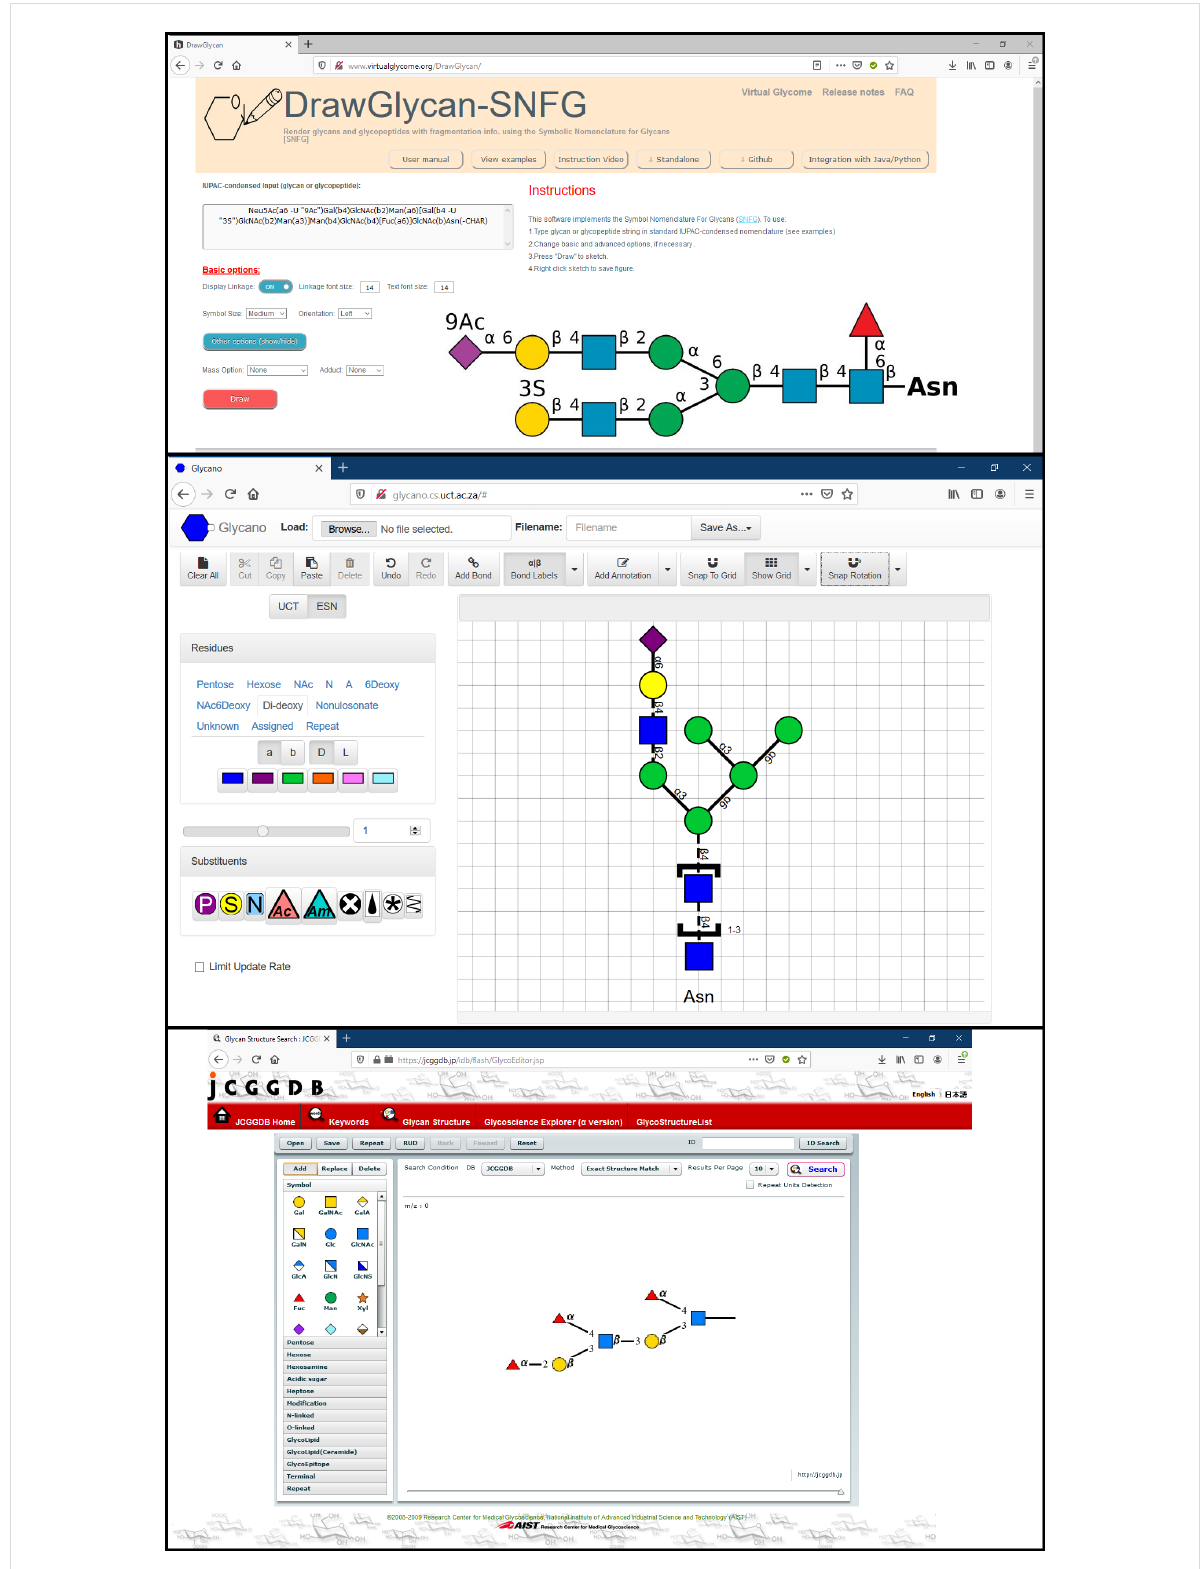
Figure 7: From top to bottom: DrawGlycan-SNFG [51] web interface with a glycan text input and the resulting image output. Glycano [52] interface with a glycan structure. GlycoEditor [53] interface, linkage selection is triggered by adding a new monosaccharide